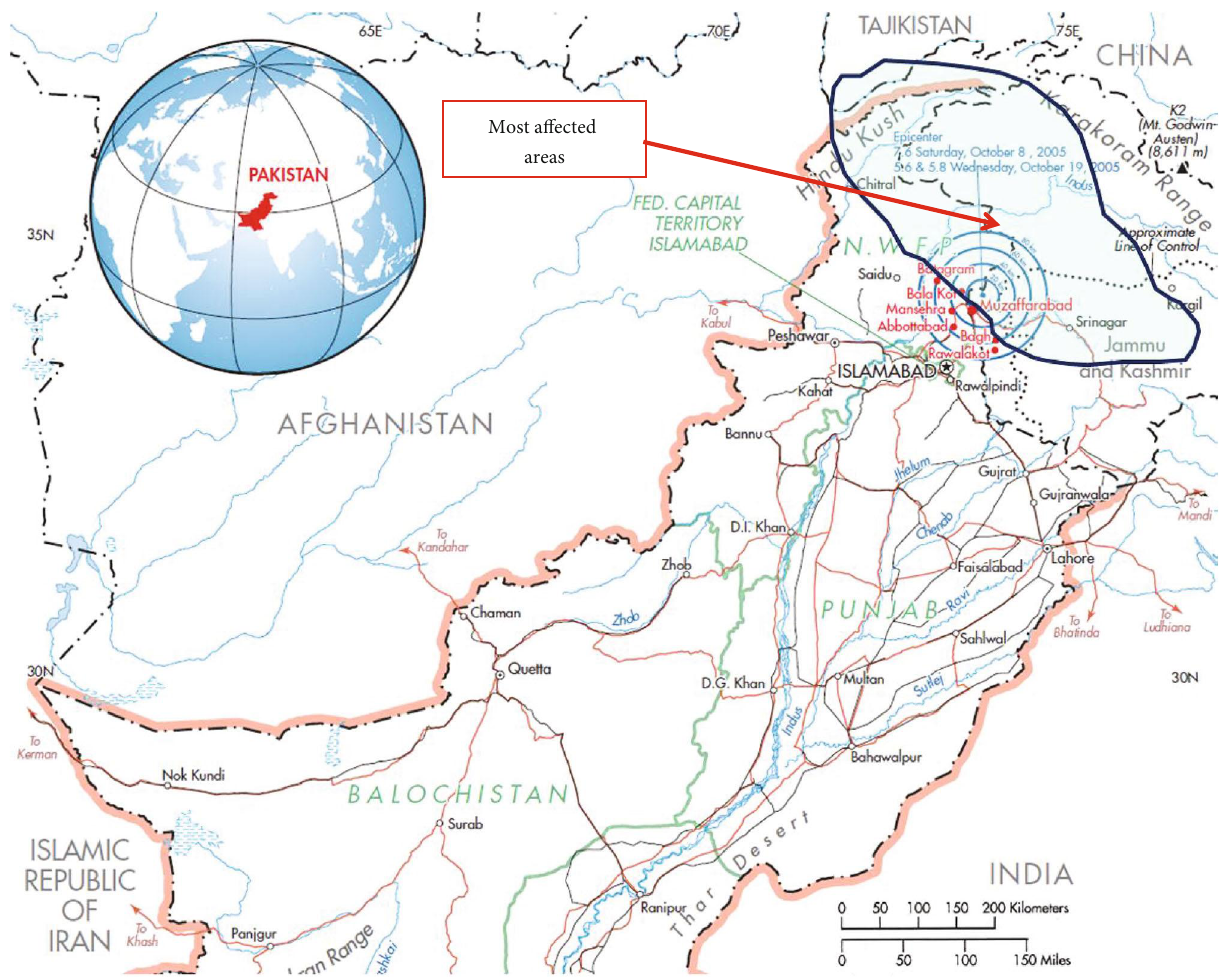
Figure 1: Map showing the epicenter of the October 08, 2005, earthquake and the most a ff ected area (adapted from